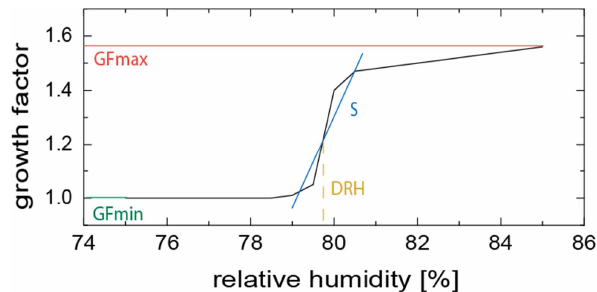
Fig. 5. Schematic of the determination of the DRH (deliquescence relative humidity) using the internal data evaluation procedure. The blue line represents the mean slope of the S-curve fitted to the data.